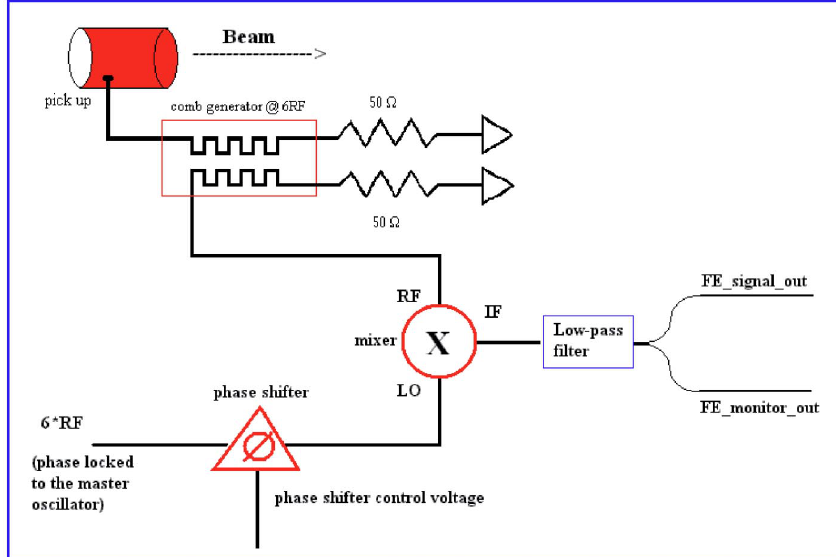
FIG. 2. (Color) Block diagram of the longitudinal feedback front end.